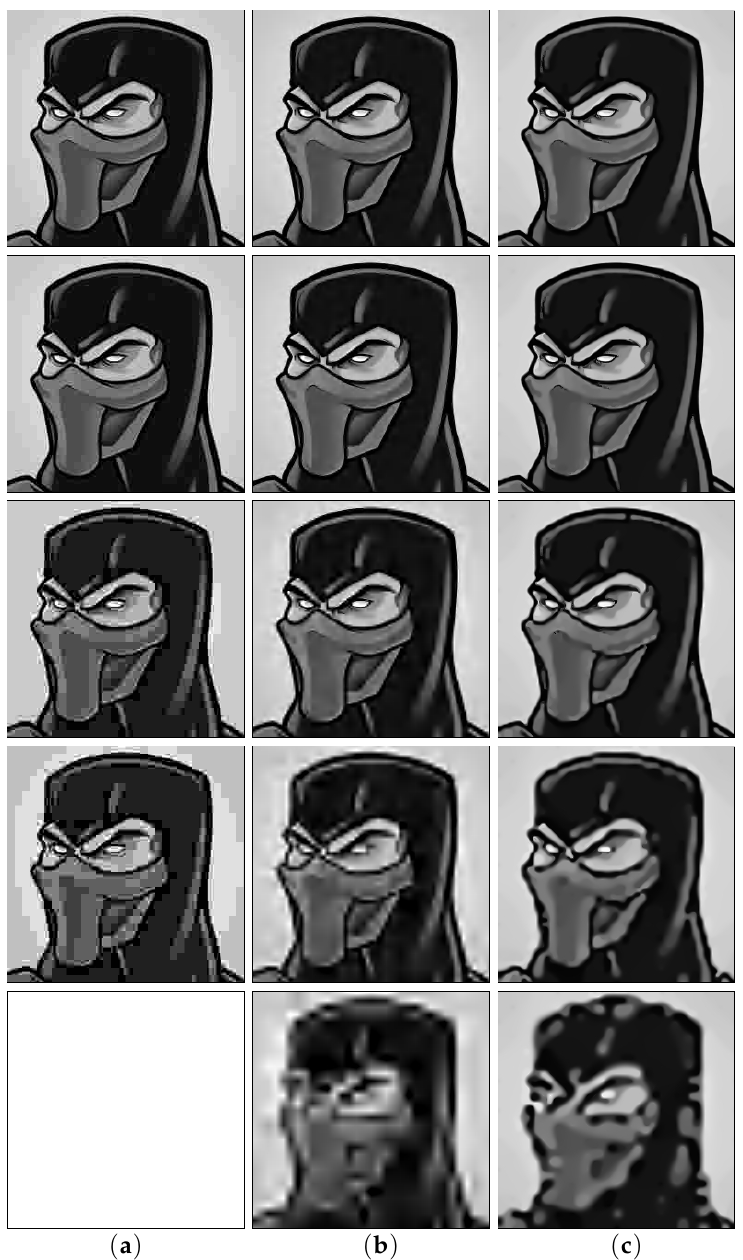
Figure 16. Comparative overview of reconstructed images for image mask ranging from 0.8 bpp ( top row ) to 0.05 bpp ( bottom row ). Compression methods: ( a ) JPEG, ( b ) JPEG 2000, and ( c )